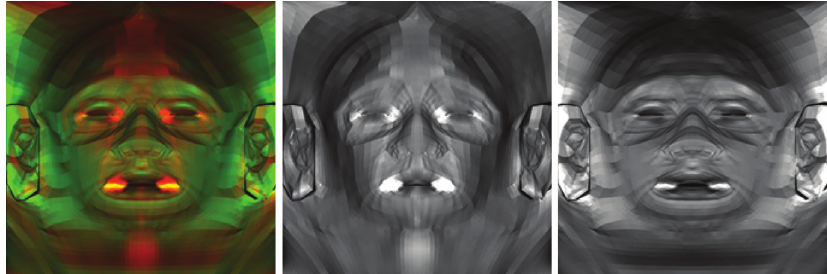
Figure 17. UV Stretch Map: Used to Adjust Texture Map Stretching Effect: UV Stretch Map in Four-Component Color Space (Left), U Coordinate Values (Center), and V Coordinate Stretch (Right).